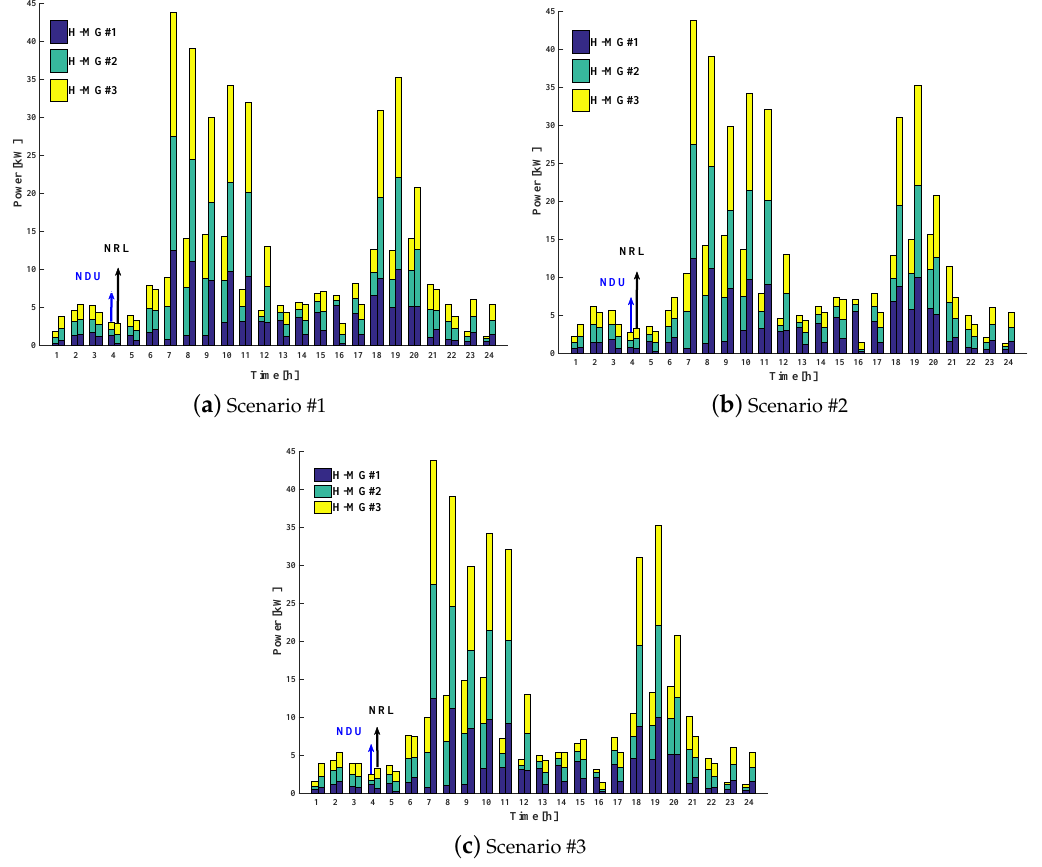
Figure 7. NDU and NRL power profiles of each